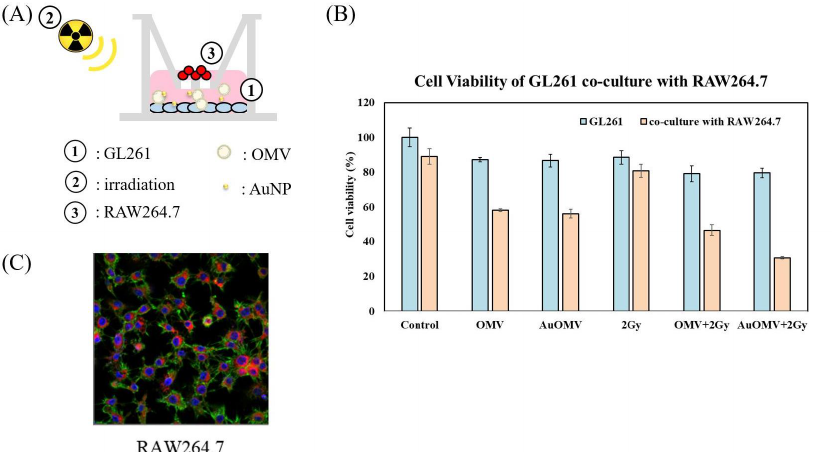
Figure 3. ( A ) GL261 glioma cells (in lower well) were treated with various treatments and co-cultured with RAW 264.7 Macrophages (in upper well) using 0.4 µ m pored transwells. ( B ) GL261 cell viability in response to various treatments when co-cultured for 24 h with RAW 264.7 cells. ( C ) Co-culture in transwell system with a 3 µ m porous membrane at the bottom of the upper chamber. Migrations of RAW 264.7 mouse macrophages towards glioma cells (chemoatxis of microphages) were noted and were labeled with VybrantTM DiD (red) in the lower